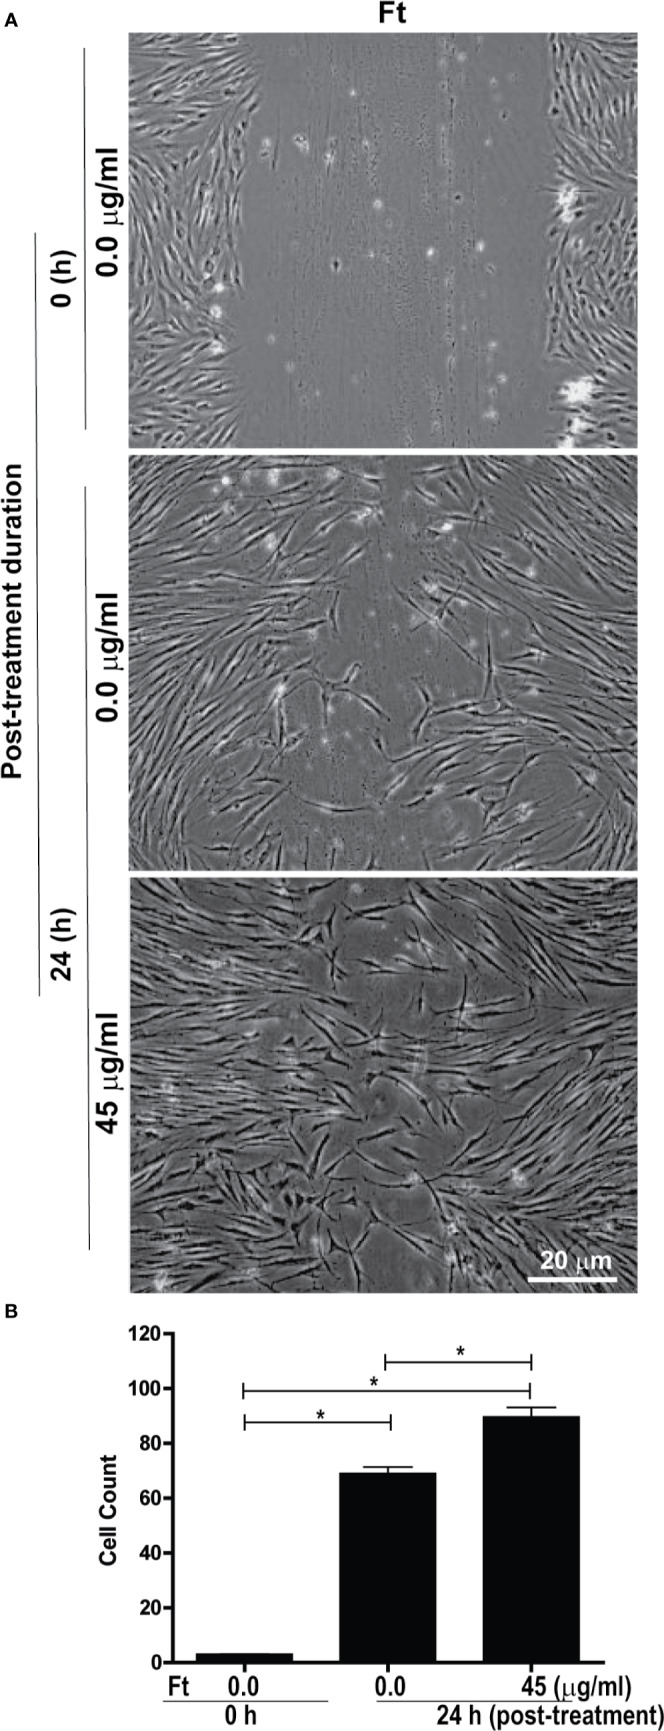
Ft promotes fibroblast migration into the scratch wound, ex vivo. Assessment of migration of fibroblasts into a midline gap evoked by incubation with Ft. (A) photographs of the midline gaps in the presence of Ft or its vehicle control at gap initiation (0 h) and 24 h following incubation. Photographs show the transparent cells on a dark background. (B) Quantitative analyses show the cell migration into the scratch wound (n = 3, p < 0.05; *, significantly different, as indicated by horizontal bars).